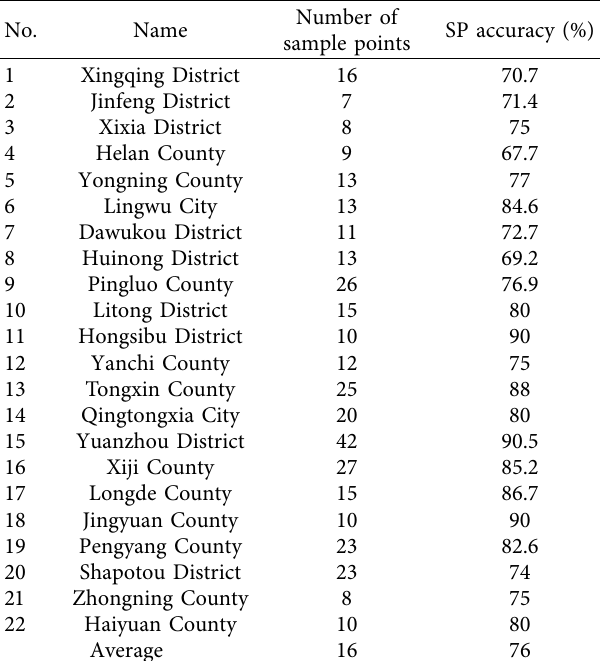
Figure 8: Normal distribution of the accuracy of the area estimates. Table 3: Sample verification of building